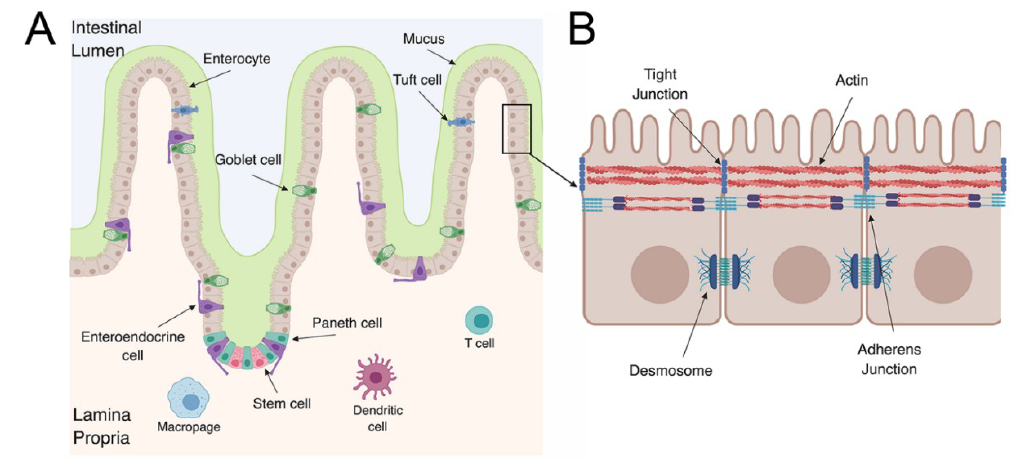
Figure 1. The gastrointestinal tract defenses. ( A ) The gastrointestinal tract is composed of numerous cell types that are important for immune activation and barrier surface defenses. The gastrointestinal epithelium is composed of enterocytes, goblet cells, Paneth cells, enteroendocrine cells, tuft cells, and stem cells. In contrast, the lamina propria is composed of immune cells such as dendric cells, T cells, and macrophages. ( B ) Polarized intestinal epithelial cells have distinct apical and basolateral domains. The apical domain contains microvilli and is closely associated with the actin cytoskeletal network.